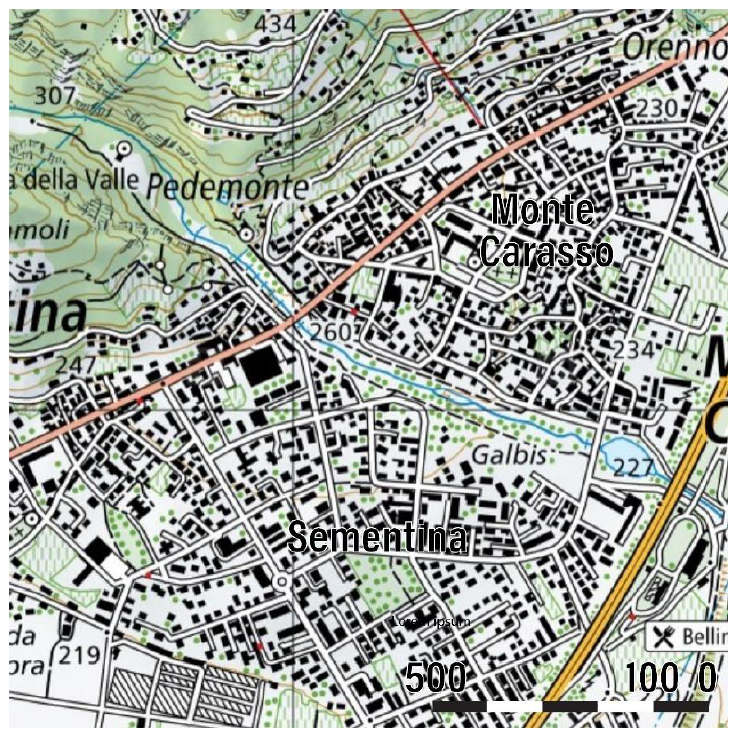
Figure 6. Contemporary topographic map of Monte Carasso (northeast) and Sementina (southwest). Source: Swisstopo 2021.